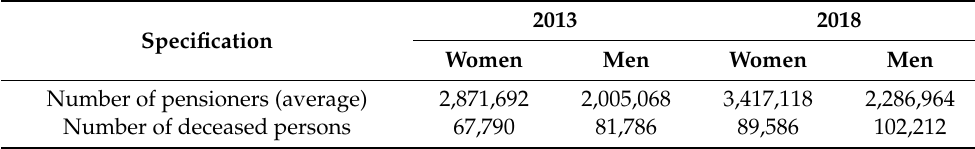
Table 1. Number of people included in the